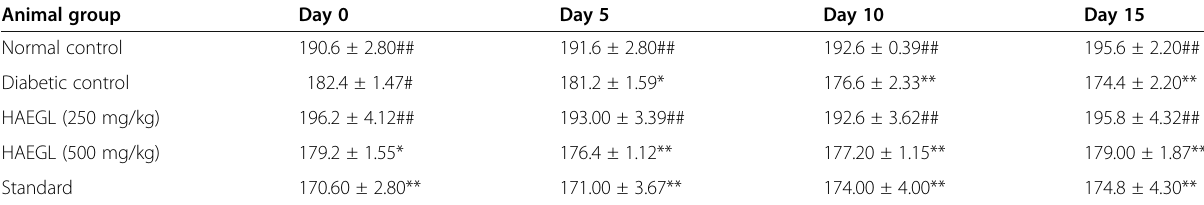
Values are expressed as mean ± SEM ( n = 5), statistical significance: * p < 0.05, ** p < 0.01, compared with that of normal control group; # p < 0.05, ## p < 0.01, compared with standard